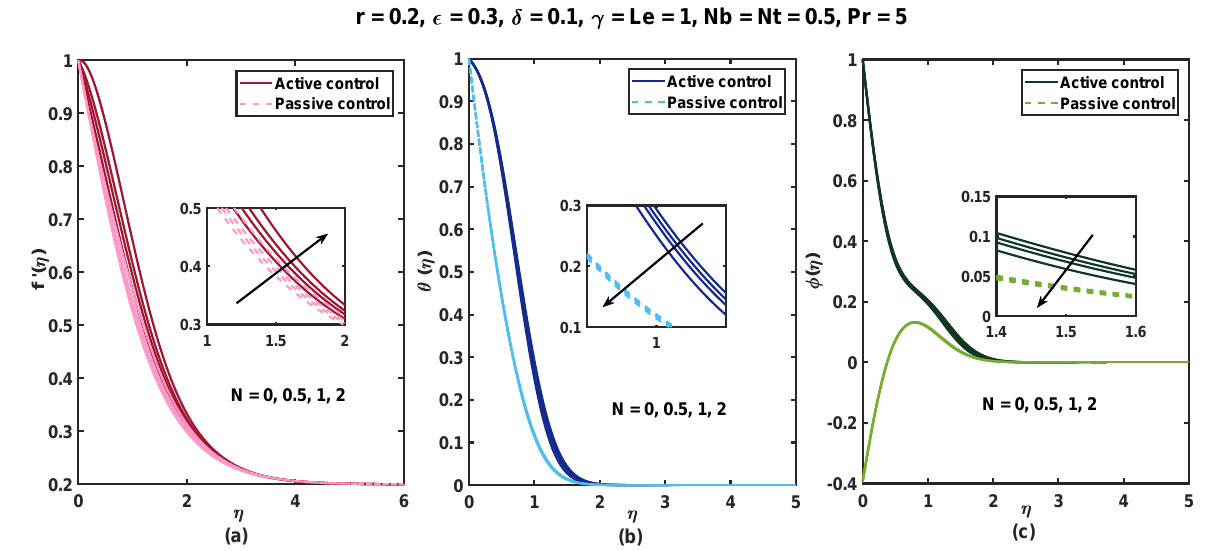
Figure 6. Impact of buoyancy ratio parameter N on ( a ) velocity, ( b ) temperature, and ( c ) nanoparticle volume fraction profiles.